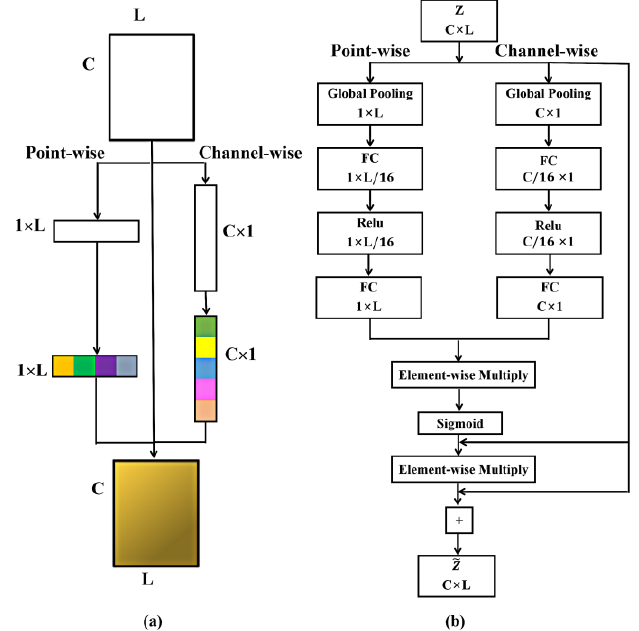
Figure 3. ( a ) Diagram and ( b ) schema of the mixed attention